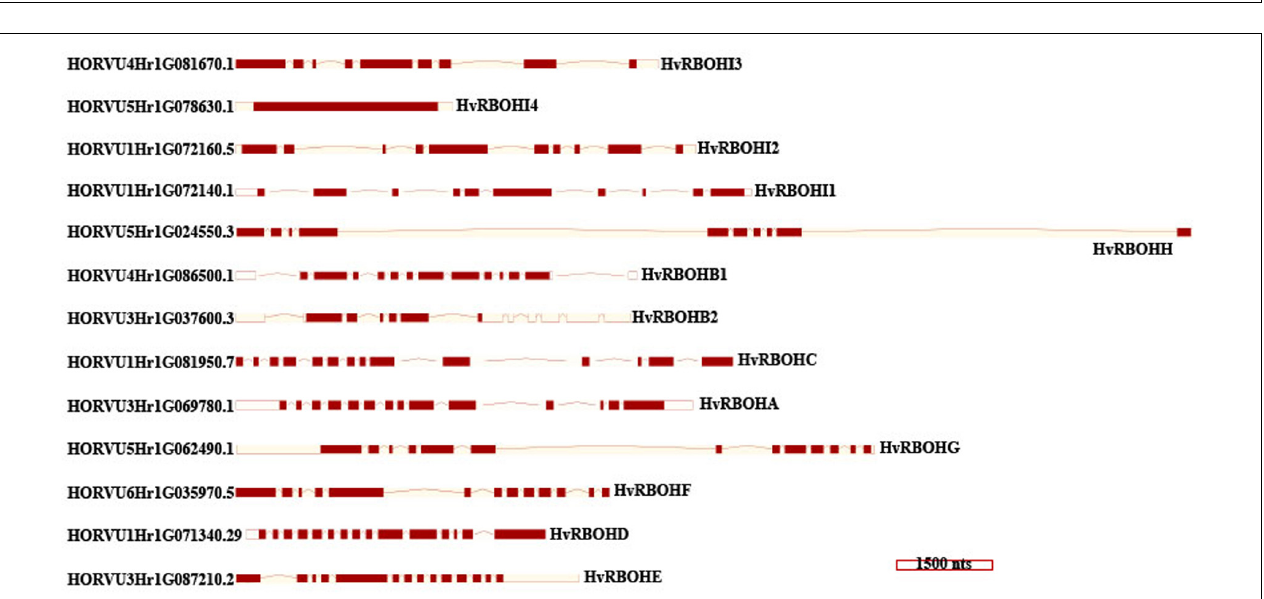
FIGURE 3 | The evolutionary history of HvRBOH protein sequences inferred using the Maximum Likelihood method and JTT matrix-based model. The tree is drawn to scale, with branch lengths measured in the number of substitutions per site.